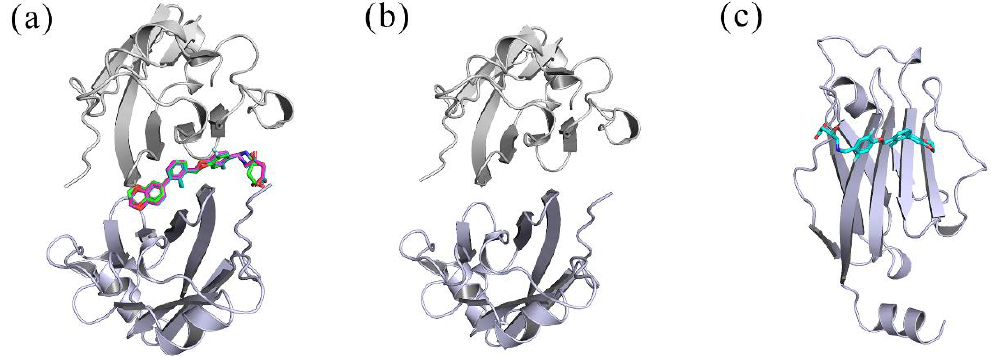
Figure 13. The initial structures of the systems used in MD simulation. ( a ) MOD, S, and R systems. ( b ) Dimer. ( c ) A PD- L1/(S)-BMS-200. The (MOD)-BMS-200, (S)-BMS-200 and (R)-BMS-200 components are shown in magenta, cyan and green, respectively.